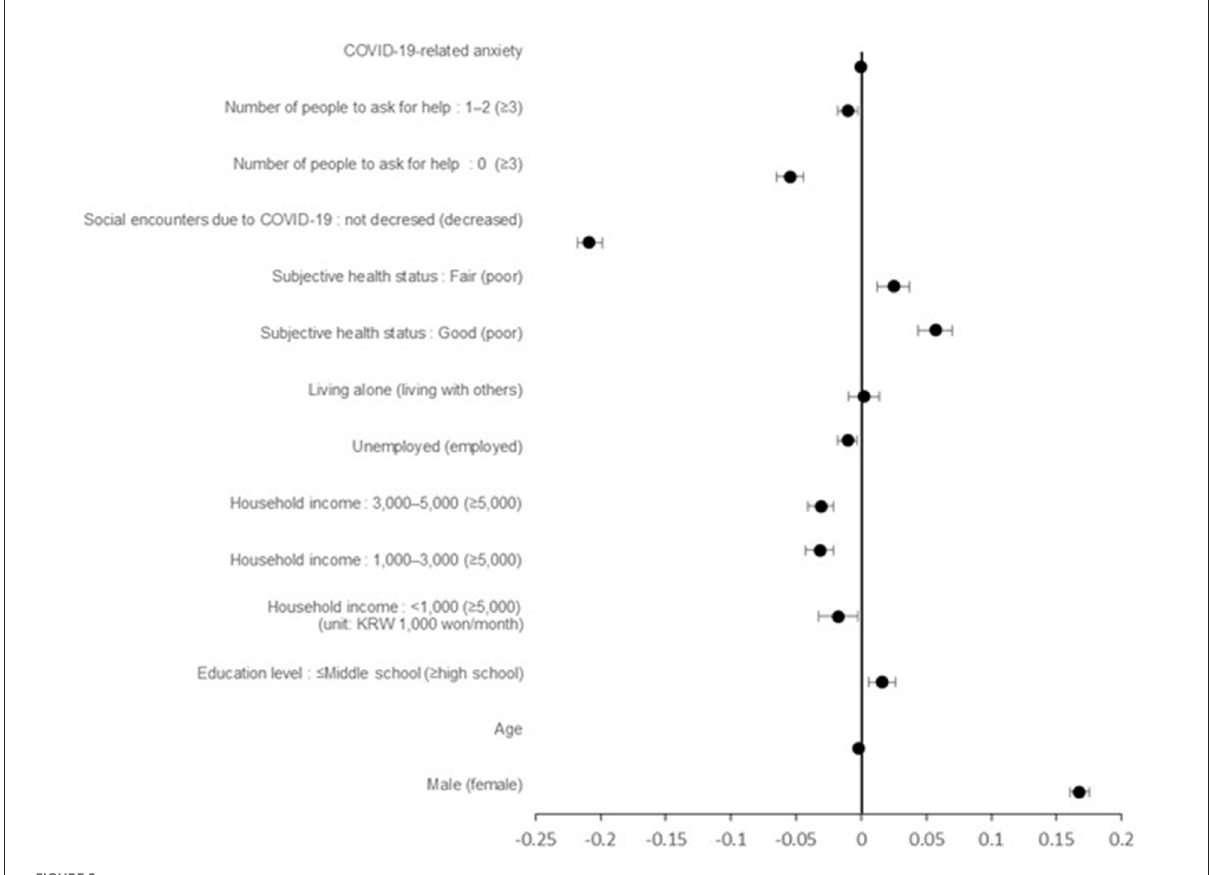
FIGURE2 Forest plot of addictive behavioral change index related factors.